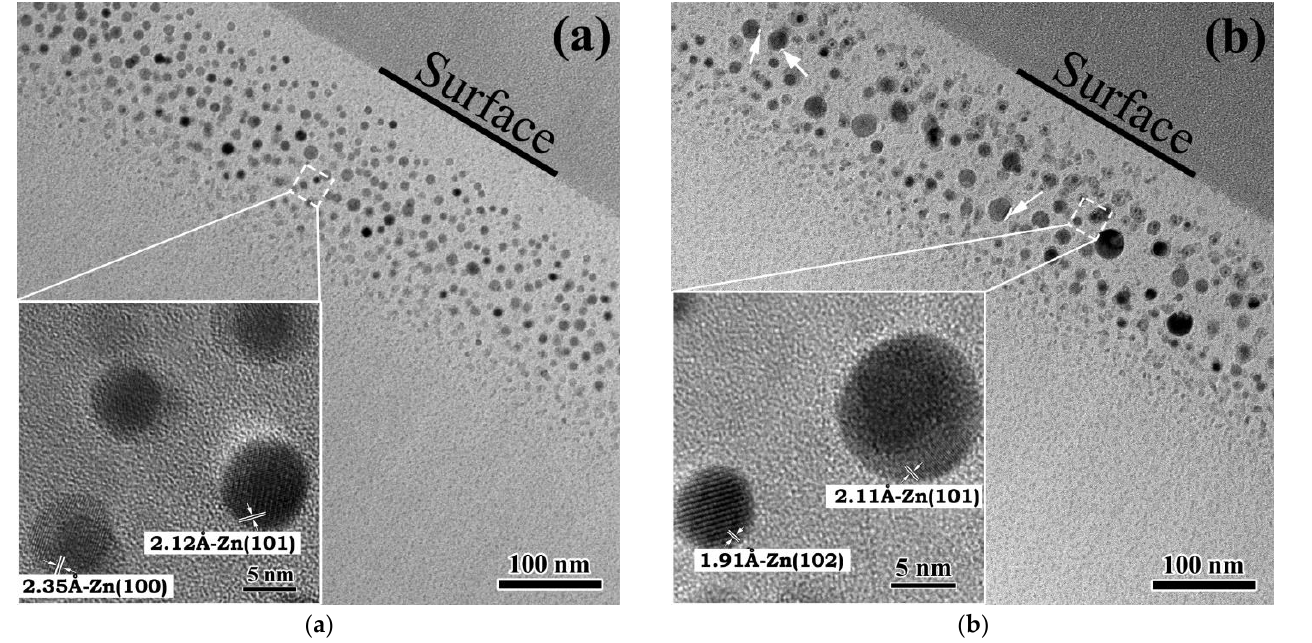
Figure 2. XTEM images of SiO 2 (600 nm)/Si samples implanted with Zn + (150 keV, 7.5 × 10 16 ions/cm 2 ): ( a ) as-implanted sample, and the samples after annealing at 973 K for ( b ) 60 min. The insets depict the HRTEM nanoparticle images.